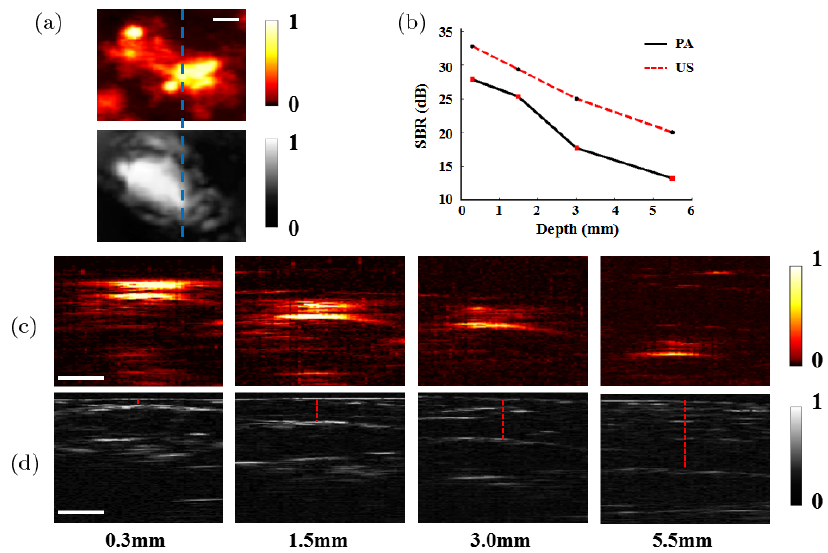
Fig. 4. Evaluation of the imaging depths and SBRs of both imaging modalities using a mouse tumor model. (a) PA (top) and ultrasonic (bottom) MAP images of a tumor without adding chicken breast. The dashed blue lines indicated the position of the selected cross-sections of PA and US. (b) SBRs vs depth. (c) and (d) PA (top row) and ultrasonic (bottom row) B-Scan images by adding di®erent thicknesses of chicken breast, respectively (The red dashed line represents the thickness of chicken breast. 0.3, 1.5, 3.0 and 5.5mm, respectively). Scale bar: 1 mm.